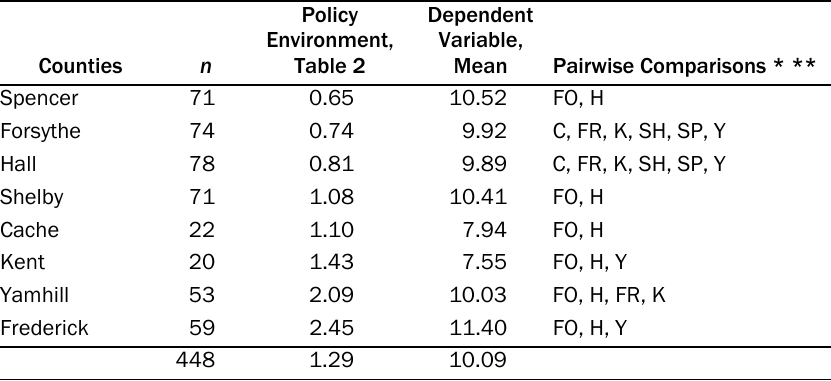
Table 4. ANOVA Results (counties listed in ascending order according to objective land use policy environment found in Table 2)